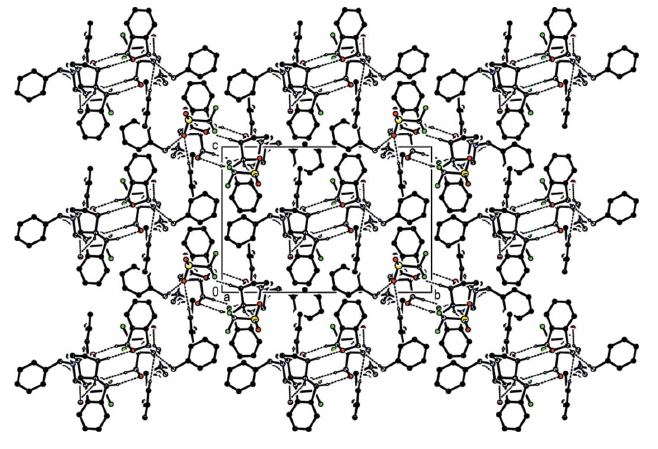
Figure 4 Packing of the title salt 1 viewed along the a axis direction with C—H (cid:2)(cid:2)(cid:2) O hydrogen bonds shown as dashed lines.